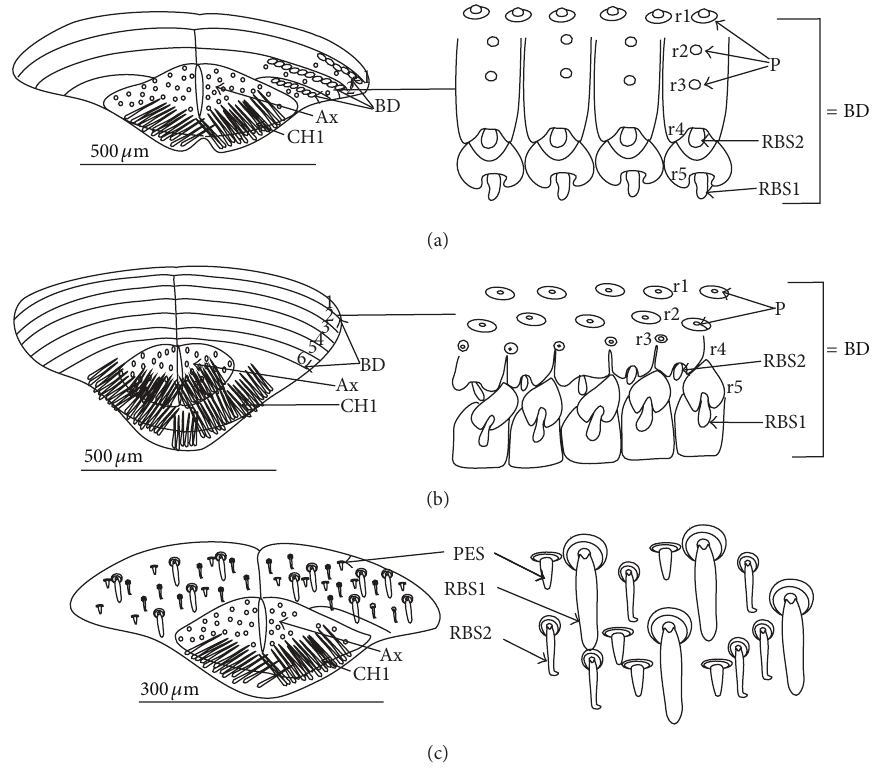
Figure 8: Types of distribution of the mechanosensilla on the dorsal surface of the labium in the Corixoidea. Sensilla placed in the transverse bands or scattered unevenly on the dorsal labial surface ((a) and (b)) and sensilla scattered unevenly on the labial surface (c). (a) Diaprepocoridae; Diaprepocoris zealandiae , two and half of bands, three rows (r1, r2, r3) of semicircular grooves with a pore, two rows of ribbon-like sensilla. (b) Corixidae; six bands, three rows (r1, r2, r3) of semicircular grooves with a pore, two rows of ribbon-like sensilla. (c) Cymatiinae; ribbon-like sensilla (RBS1, RBS2) and peg sensilla